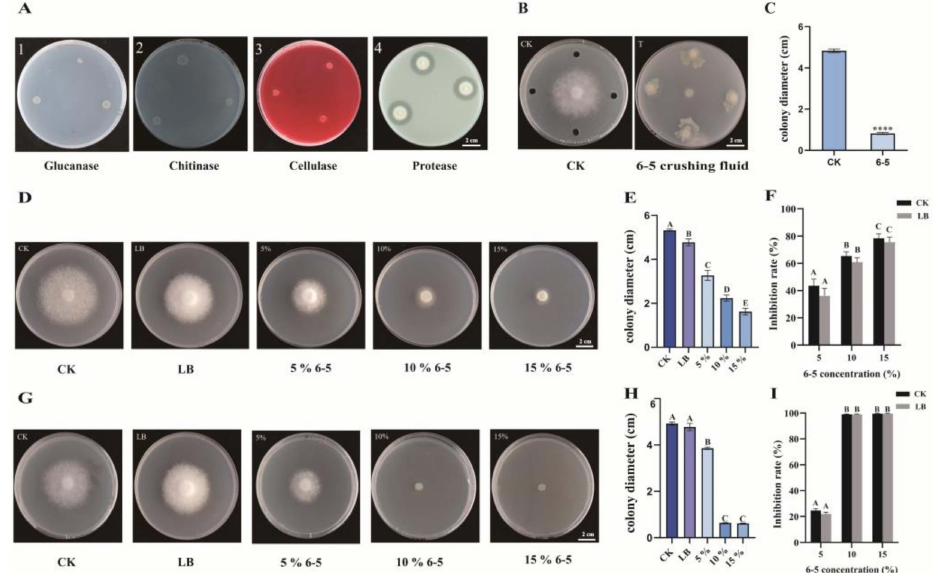
Figure 3. Detection of extracellular enzymes of 6-5 and localization of antagonistic substances of 6-5 against Phytophthora infestans . ( A ) The ability of 6-5 to secrete extracellular enzymes; ( B ) colony morphology of strain T30-4 under the treatment of 6-5 bacterial crushing fluid; ( C ) the colony diameter of strain T30-4 under the treatment of bacterial crushing fluid; ( D ) growth of strain T30-4 under different concentrations of 6-5 cell-free culture filtrate (filter sterilization); both CK and LB were set as controls, CK represents ordinary rye agar medium, and LB represents rye agar medium added with 10% LB. ( E ) the colony diameter of strain T30-4 under different concentrations of 6-5 cell-free culture filtrate (filter sterilization). ( F ) the inhibition rate of strain T30-4 by different concentrations of cell-free culture filtrate (filter sterilization). CK: the inhibition rate was calculated by comparing with the CK group; LB: the inhibition rate was calculated by comparing with the LB group. ( G ) growth of strain T30-4 under different concentrations of 6-5 cell-free culture filtrate (autoclaving); both CK and LB were set as controls, CK represents ordinary rye agar medium, and LB represents rye agar medium added with 10% LB. ( H ) the colony diameter of strain T30-4 under different concentrations of 6-5 cell-free culture filtrate (autoclaving). ( I ) the inhibition rate of strain T30-4 by different concentrations of cell-free culture filtrate (autoclaving). CK: the inhibition rate was calculated by comparing with the CK group; LB: the inhibition rate was calculated by comparing with the LB group. **** p < 0.0001, capital letters indicate a significant difference ( p <